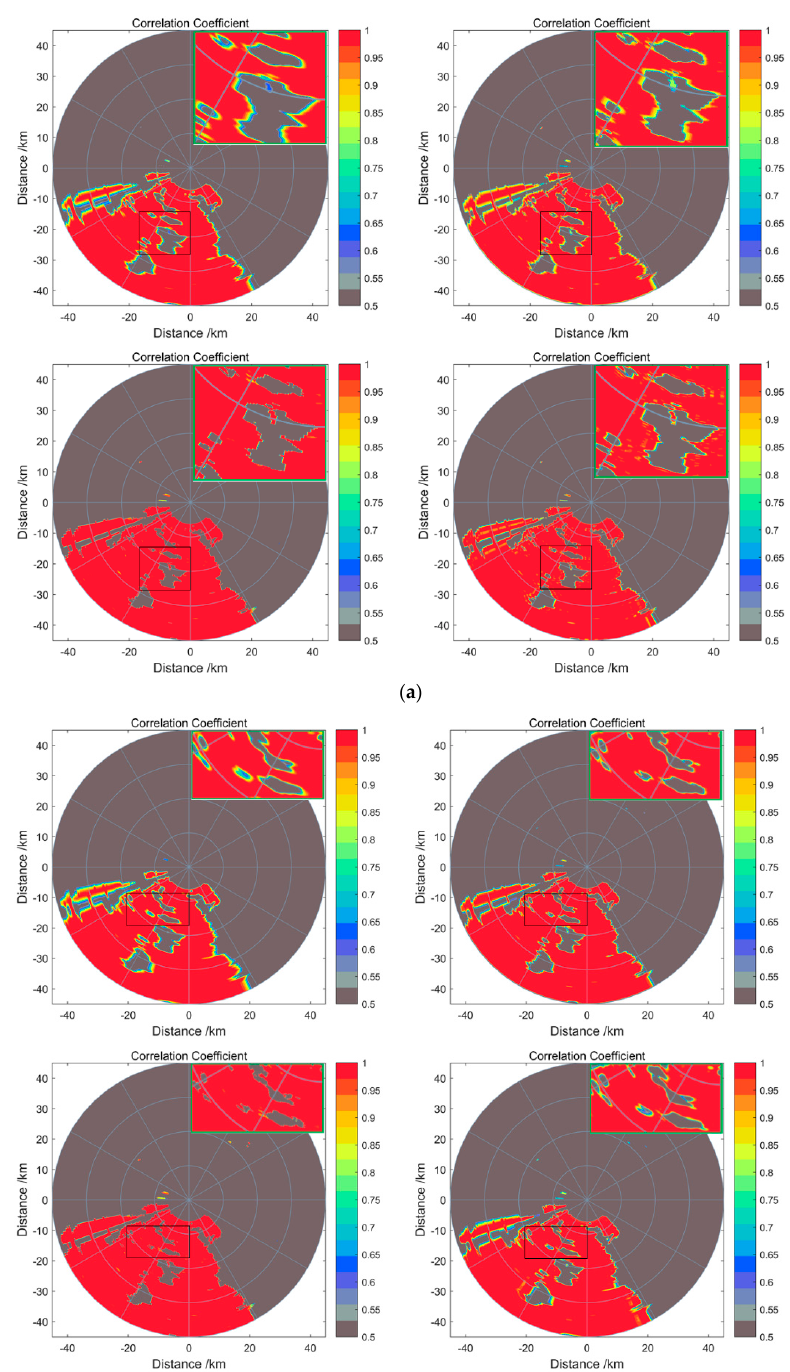
Figure 9. Radar echo reconstruction comparison on correlation coefficient data. (a) 2 × reconstruction of correlation coefficient data. From left to right and top to bottom: bicubic interpolation echo, the reconstructed echo by IBP [13] (PSNR = 71.6387; SSIM = 0.9998), original radar echo, and the reconstructed echo by the proposed NSSR algorithm (PSNR = 73.3858; SSIM = 0.9999). (b) 4 × reconstruction of correlation coefficient data. From left to right and top to bottom: bicubic interpolation echo, the reconstructed echo by IBP [13] (PSNR = 66.7864; SSIM = 0.9994), original radar echo, and the reconstructed echo by the proposed NSSR algorithm (PSNR = 68.8336; SSIM = 0.9998). The tested data is the first elevation cut of the XPRAD, which is the same as the data used in Figure